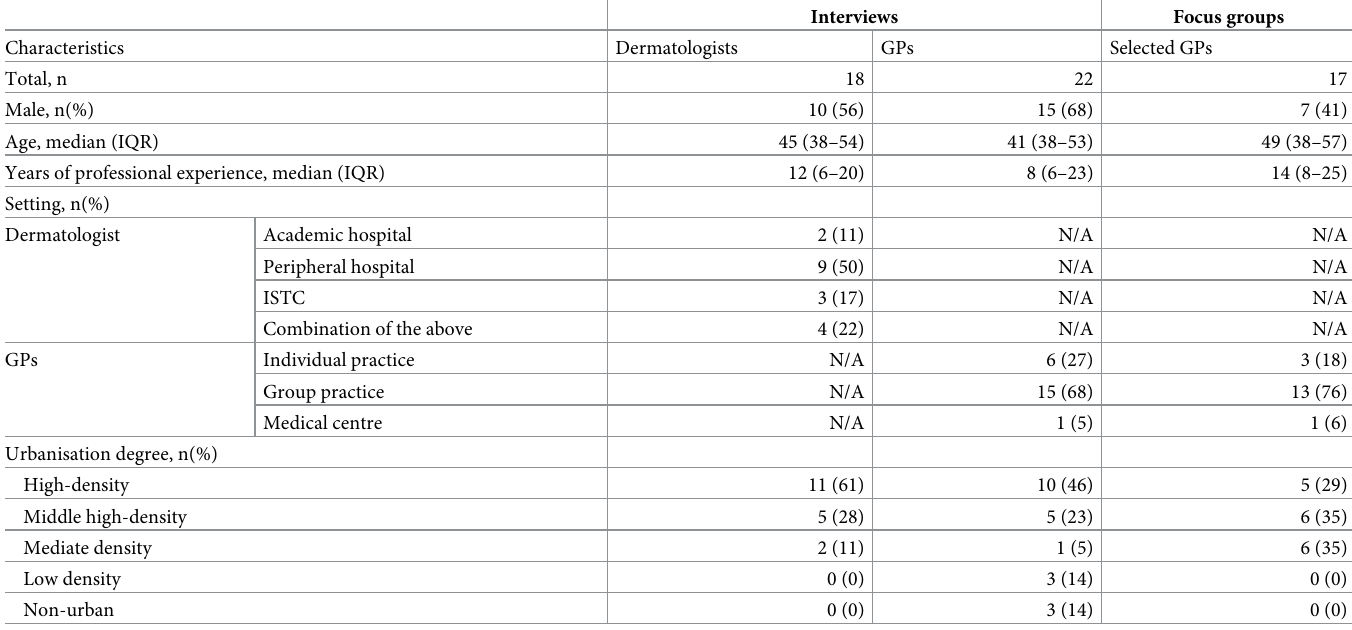
Table 1. Characteristics of